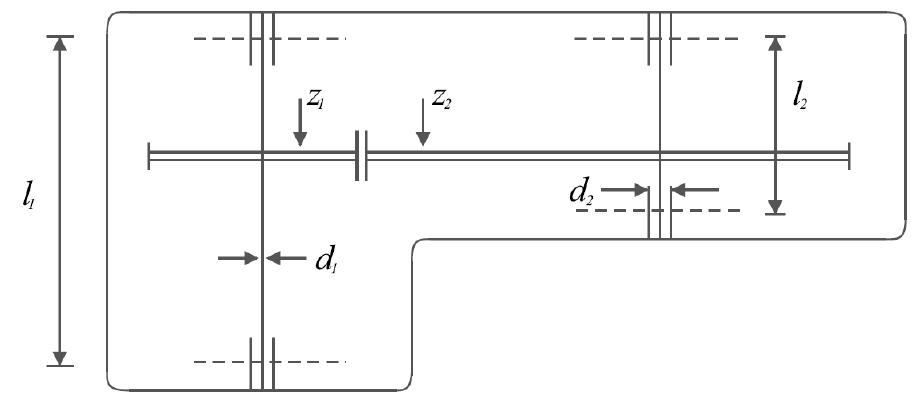
Figure 7. Schematic of speed reducer design.